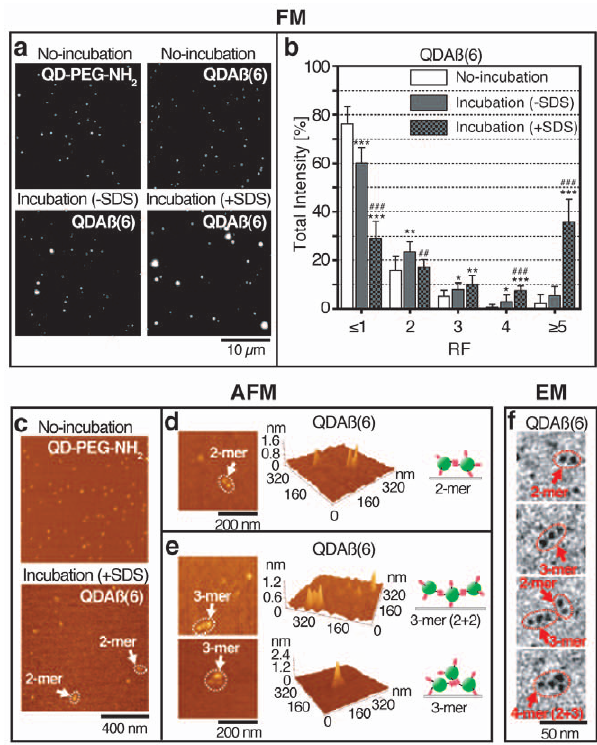
Figure 2. Imaging of QDA b oligomers. (a) QD-PEG-NH 2 (top left), non-incubated-QDA b (6) (top right: stored in water for 3 weeks on ice), incubated-QDA b (6) without SDS (bottom left: in PBS for 1 day at 37 u C), and incubated-QDA b (6) with SDS (bottom right: in PBS with 1 mM SDS for 1 day at 37 u C) were observed by regular fluorescence microscopy using a 100x objective lens with QD filter set. (b) Distribution of QDA b molecules belonging to each RF classes. The frequency of total intensity shows the sum of RF values of all spots belonging to the RF class. Error bars indicate standard deviation (SD, n=10). * (or # ), ** (or ## ), and *** (or ### ) denote 0.01 , P , 0.05, 0.001 , P , 0.01, and P , 0.001, respec- tively. * are non-incubated- versus incubated-samples ( 2 SDS or + SDS) and # are -SDS versus + SDS samples. (c) QD-PEG-NH 2 and incubated- QDA b (6) with SDS under the same conditions as in (a) were observed by AFM. (d and e) Typical AFM images of dimeric (d) and trimeric (e) species. Trimers were classified into two types: two dimers (top, 2 + 2) or one trimer (bottom) of A b peptides. (f) Typical images of dimers, trimera, and tetramers by electron microscopy observations.